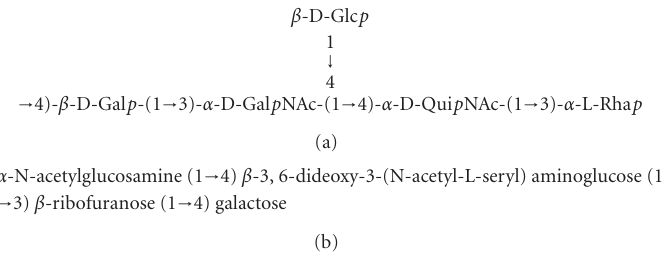
Figure 2: Oligosaccharide structures of known Salmonella and E. coli O antigens: A. Salmonella Dakar O28 O antigen structure [22] and B. E. coli O114 O-specific polysaccharide [23]. Gal: galactose, Glc: glucose, GalNAc: N-acetylgalactosamine, QuiNAc: N-acetylquinovosamine (N-acetyl-2-amino-2,6-dideoxy glucose); Rha: rhamnose.